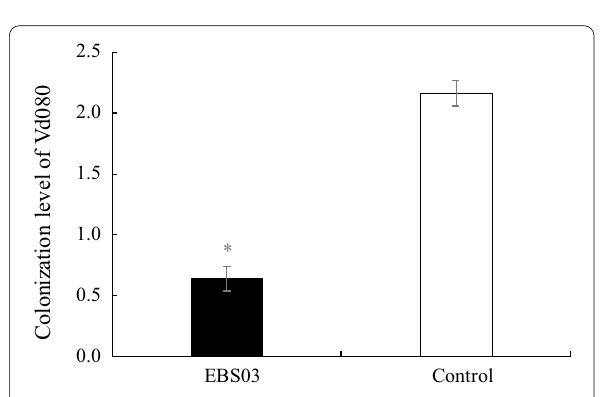
Fig. 9 Colonization level of V. dahliae in hypocotyl of cotton. * indicates a significant difference at the 0.05 probability